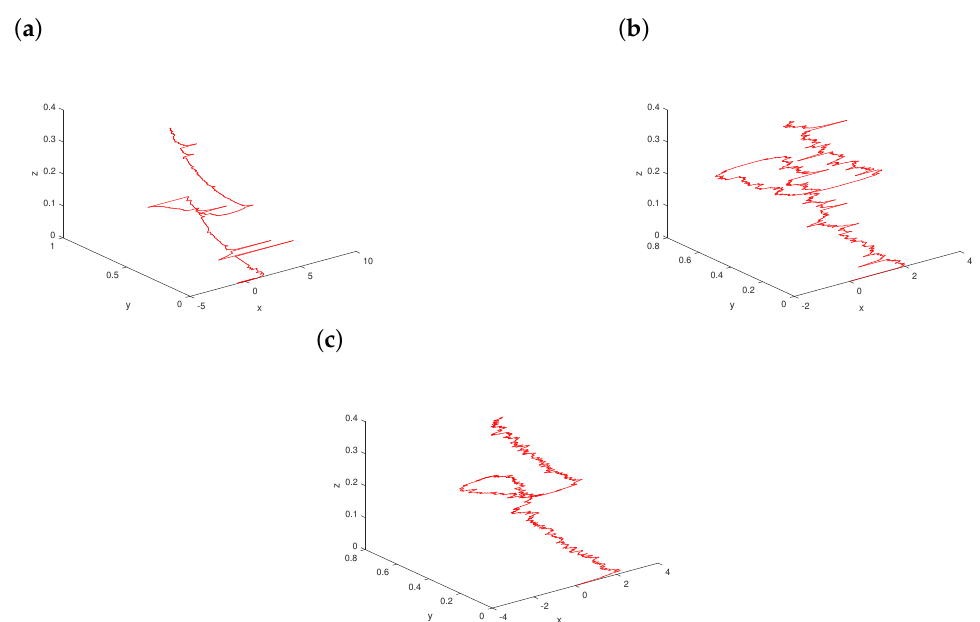
Figure 2. The evolution of system (7) for the choice of initial conditions x ( 0 ) = y ( 0 ) = z ( 0 ) = 0 at the fixed noise intensity σ = 0.5 with a scaling parameter (cid:101) = 0.05 and a gradual increase in the stability